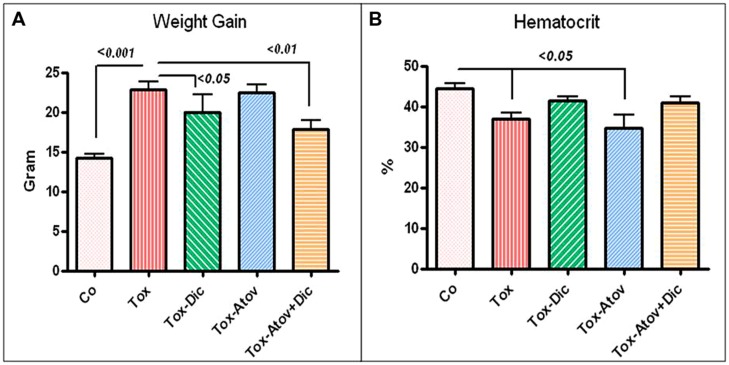
(A)
Toxoplasma infection caused significant anemia in sham treated dams (Tox). Combination diclazuril plus atovaquone therapy (Dic + Atov) and diclazuril monotherapy (Dic) protected dams but atovaquone (Atov) monotherapy had no effect. (B) Body weight gain during pregnancy in normal sham controls (Control) compared with excess pathological weight due to accumulation of inflammatory fat in Toxoplasma infected (Tox) sham treated dams (p < 0.001). Combination therapy with diclazuril plus atovaquone synergistically protected dams (p < 0.01) and to a lesser extent diclazuril monotherapy (p < 0.05) prevented pathological fat accumulation and excess weight gain. Atovaquone monotherapy had no significant effect (n = 6–8/group).